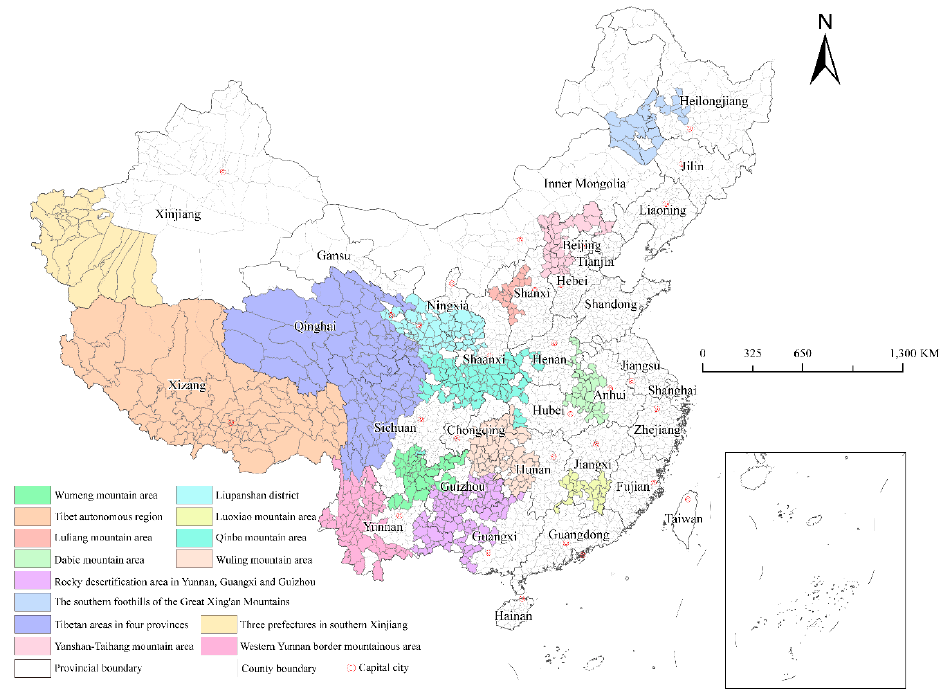
Figure A1. The 14 concentrated and contiguous poverty-stricken areas designated by the Chinese Central Government in 2012 (680 counties in total).